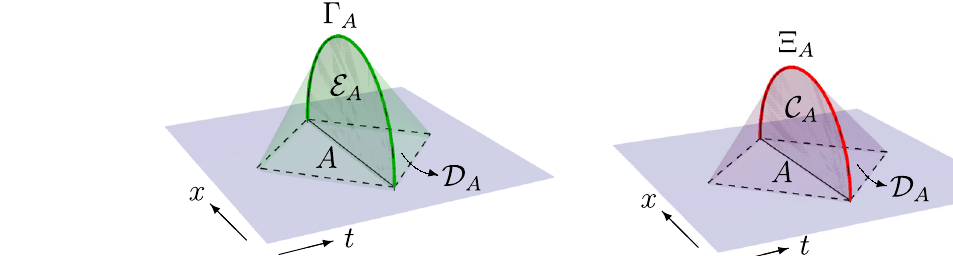
spatial surface (cid:5) A on which the latter geodesics intersect is the causal information surface defined in [17]. In a few situations (cid:5) A = (cid:2) A , and the two types of wedges coincide. This happens in particular when A is a spherical region in the vacuum of a d -dimensional conformal field theory, which for d = 2 gives rise to the anti-de-Sitter-Rindler wedge considered throughout most of this